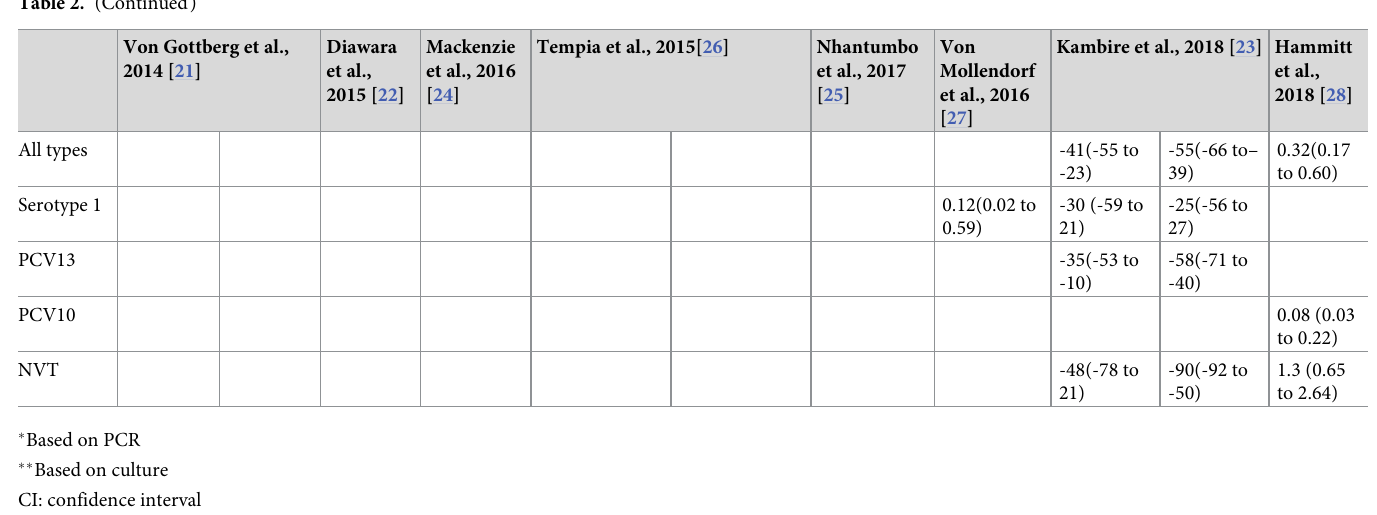
PLOS ONE | https://doi.org/10.1371/journal.pone.0212295 February 19,